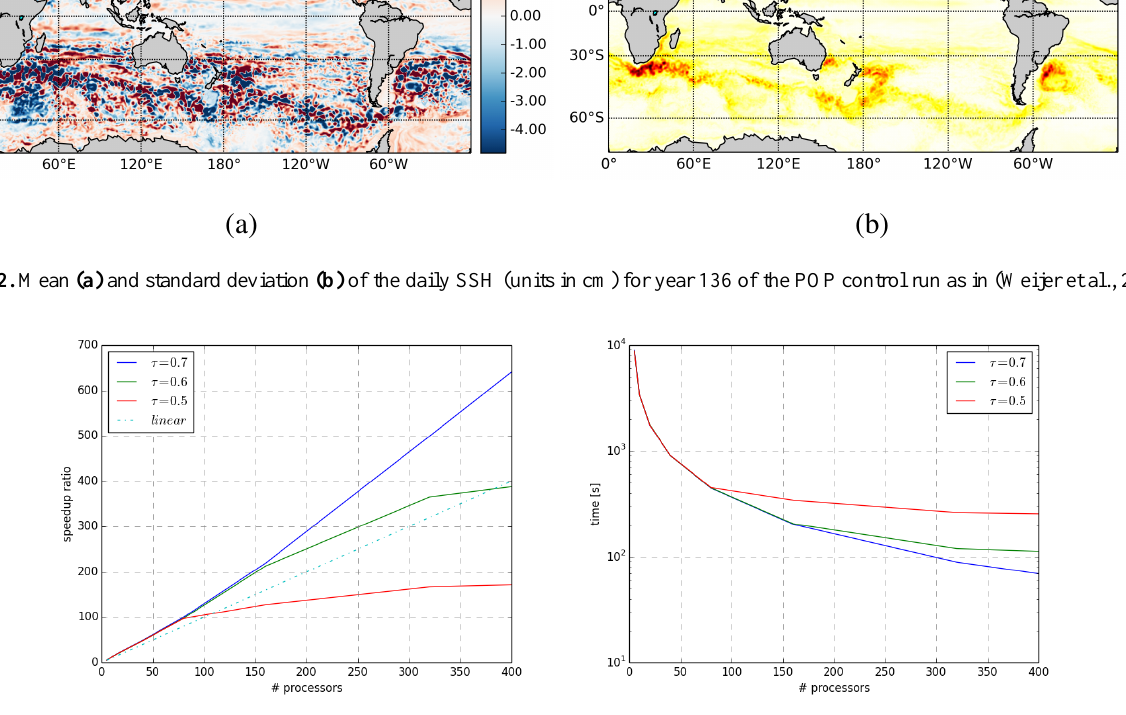
Figure 3. Speedup ratio (a) for the parallel construction of SSH climate networks from the POP model data having 0.4 ◦ spatial resolution. The shown speedup also includes the parallel reading and reordering of the input time series. The corresponding execution times (in seconds) over different sizes of computing processors starting from five processors upwards is given in (b).